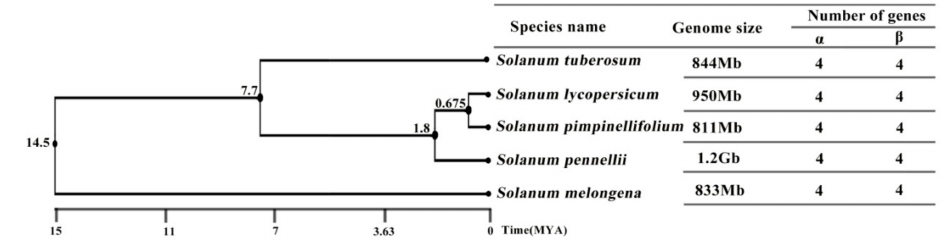
Figure 3. Evolutionary time, genome size, and numbers of CIN genes within each plant species. Evolutionary time in million years ago (MYA) shown in each line, and scale shown at the bottom of the species